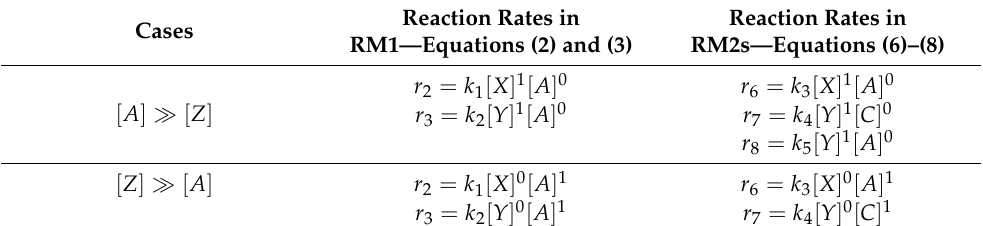
Table 2. The expressions for the reaction rates in RM1 and RM2s for the two cases in which the quantity of money is much larger than the quantity of products and vice versa. Reaction Rates in Reaction Rates in Cases RM1—Equations (2) and (3) RM2s—Equations (6)–(8) r 2 = k 1 [ X ] 1 [ A ]